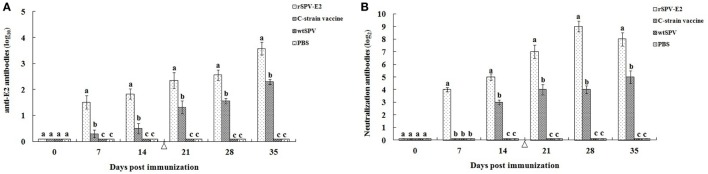
Antibody response detection in immunized pigs (n = 5). (A) The anti-E2 antibody response to rSPV-E2 following vaccination. (B) The classical swine fever virus-specific neutralizing antibody response to rSPV-E2 following vaccination. Different letters (a–c) indicate significant difference (P < 0.05) between groups. Δ Indicate the time point (14 dpi) of boost of pigs.